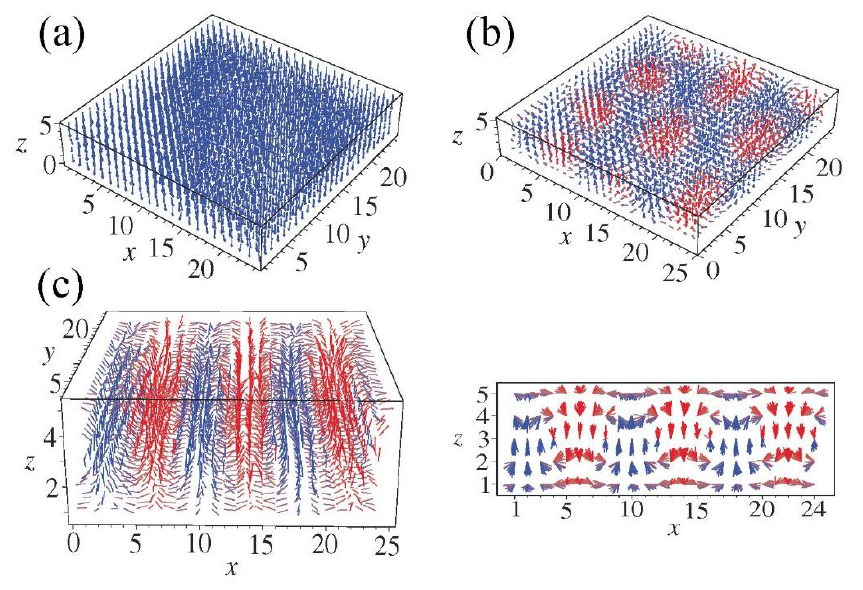
Figure 5. Three-dimensional polarization patterns in (001) PZT films having a 5 unit-cells thickness and under a compressive strain of 2.65% at 10 K. Panels ( a ), ( b ) and ( c ) correspond to the screening parameter of 94.5%, 87.7%, and 80.8%, respectively. The right part of ( c ) shows the projection of the three-dimensional picture into an xz plane. Red (blue) indicates local dipoles having a positive (negative) component along the z axis. 24 × 24 × 40 supercells are used. (Reprinted with permission from [151]; Copyright 2004 by the American Physical